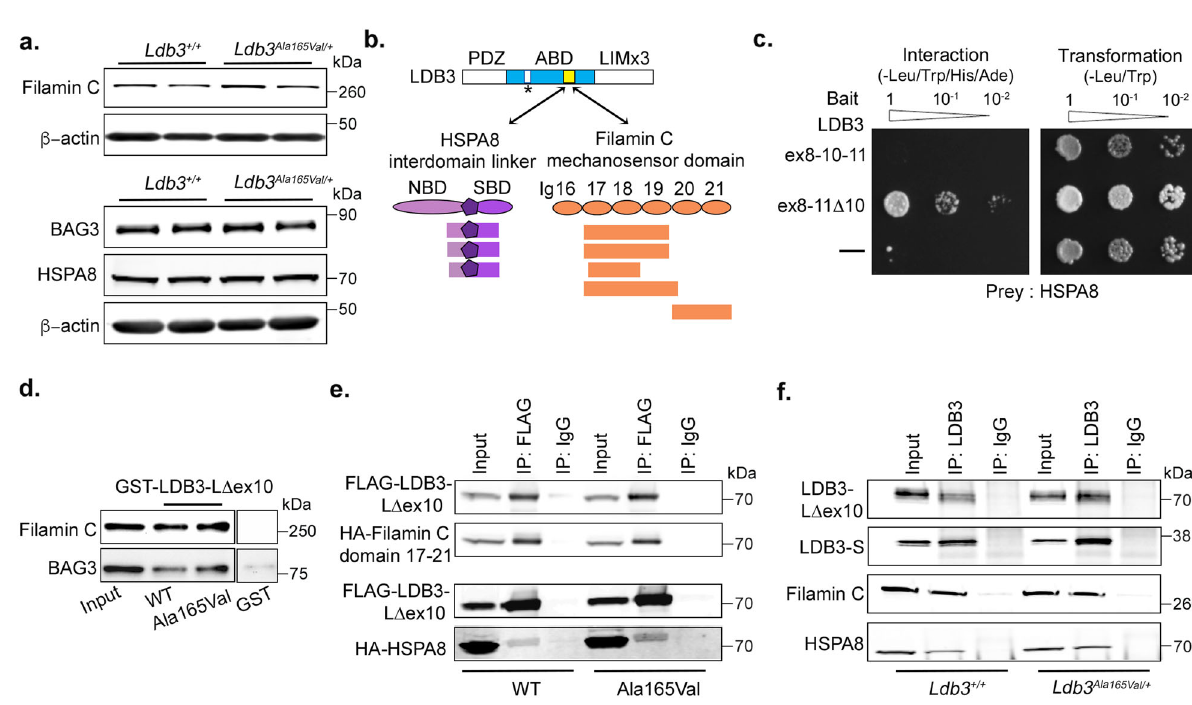
Fig. 5 Characterization of LDB3 interactions with fi lamin C and HSPA8. a Representative immunoblots showing protein levels of fi lamin C, BAG3, and HSPA8 relative to β -actin in the vastus muscle of 8-month-old Ldb3 Ala165Val/ + mice and Ldb3 + / + littermates. Data represent n = 5 mice per group and triplicate assays. b Schematics of LDB3 interaction with the mechanosensing domains Ig17 – 21 of fi lamin C and its chaperone HSPA8 as identi fi ed by yeast two-hybrid (Y2H) screen of a human skeletal muscle cDNA library. See Supplementary Table 1. Locations of the LDB3 bait encoded by exons 8-11 Δ 10 (yellow) and the p.Ala165Val mutation (white; asterisk) within actin-binding domain (ABD; blue) are shown in LDB3-L Δ ex10 isoform 7,17 . Domain composition of the prey clones are shown. c Pairwise Y2H assays demonstrating interaction between LDB3 peptides and HSPA8. Positive interactions show yeast growth on the media de fi cient in HIS3 and ADE2 . Yeast cells co-transformed with empty bait vector and the HSPA8 prey show no growth (labeled – ). Transformation ef fi ciency was uniform for all constructs. Sequential tenfold yeast dilutions are shown. d GST pulldown assay shows that GST- tagged wildtype (WT) and mutant LDB3-L Δ EX10 (Ala165Val) but not GST alone pulled down fi lamin C and its interactor the CASA cochaperone BAG3 from the vastus muscle lysates of wildtype mice. Data represent n = 3 mice and triplicate assays. e Co-immunoprecipitation (co-IP) assays show that a FLAG antibody pulled down the FLAG-tagged WT and mutant (Ala165Val) LDB3-L Δ ex10 together with HA-tagged fi lamin C rod domain Ig17 – 21 and HSPA8 in Cos7 cells. Data represent triplicate assays. The proteins were detected with anti-FLAG and anti-HA antibodies. f Co-IP assays show that an LDB3 antibody pulled down LDB3 isoforms together with fi lamin C and HSPA8 from the tibialis anterior muscle lysates of Ldb3 Ala165Val/ + and Ldb3 + / + mice. Data represent n = 3 mice per group and triplicate aggregation of the mutant LDB3 protein in muscle fi bers. The pathways. Further, pathology studies show that muscle fi bers with LDB3 p.Ala165Val mutation destabilizes fi lamin C and stalls the protein aggregates develop the Z-disc myo fi brillar disruption in removal of damaged fi lamin C through impaired PKC α and skeletal muscle of Ldb3 Ala165Val/ + mice. TSC2-mTOR signaling at arguably the most important mechan- LDB3 is well-poised to play a role in mechanosensor function osensor hub in the Z-disc of skeletal muscle (summarized in in striated muscle. Homozygous LDB3-null mice display frag- Fig. 7). The presence of chaperones and ubiquitin in these protein mented Z-discs in the diaphragm muscle after birth, but not aggregates likely represents impairment of protein degradation during embryonic development 11 . Since the diaphragm does not